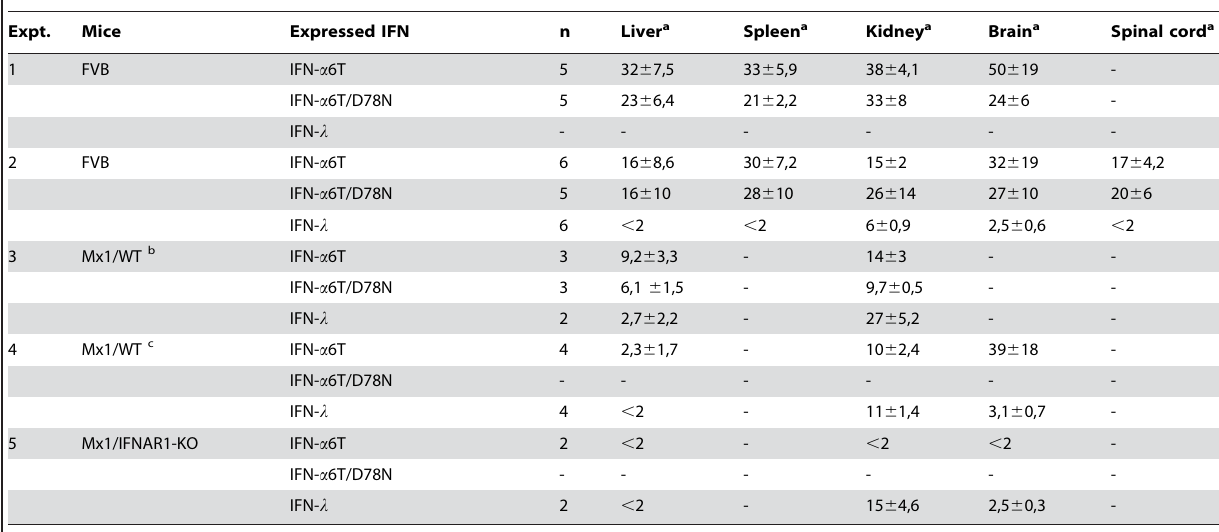
Table 4. Induction of OASl2 gene expression in response to circulating IFNs.